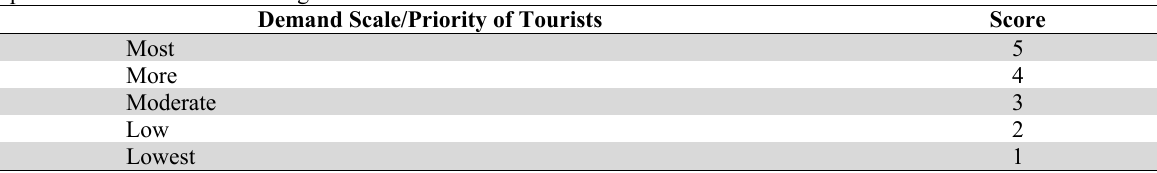
Opinion scales of Thai and foreign